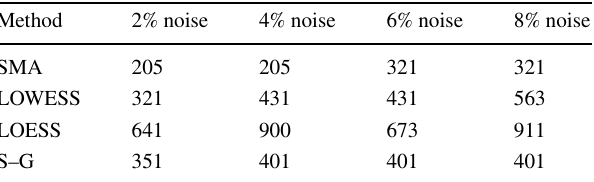
Table 2 Optimum spans for the regressive smoothing methods with different levels of noise